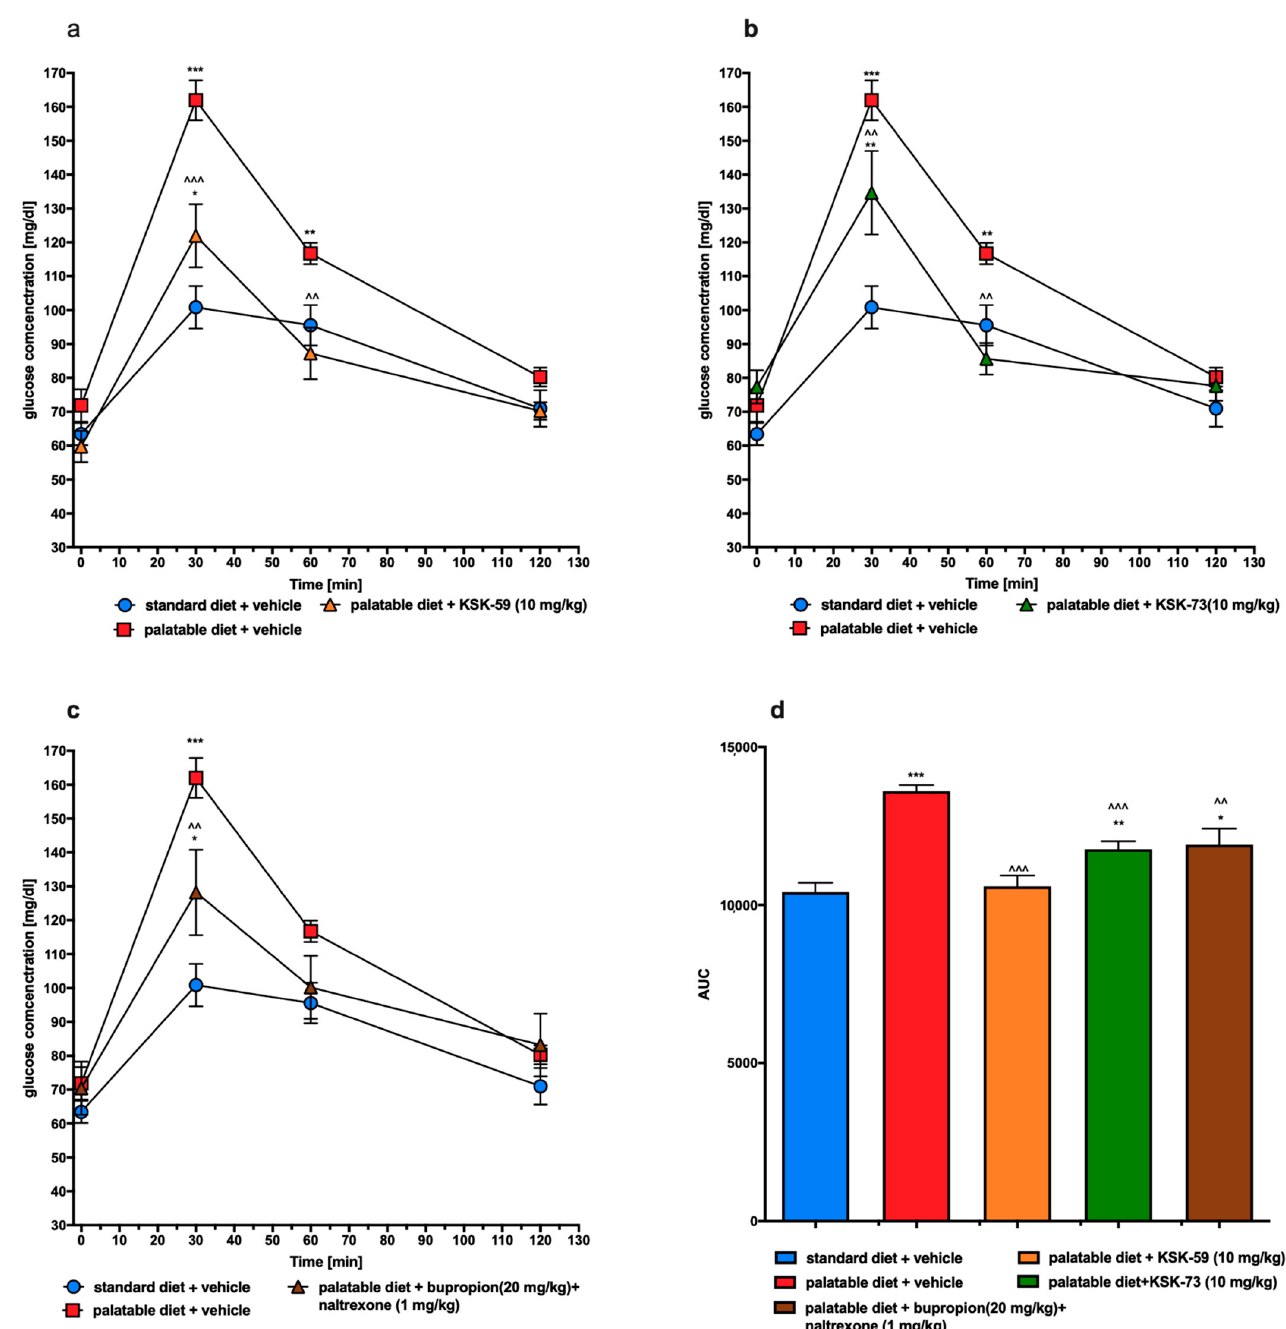
Figure 6. Glucose tolerance test. Results are expressed as means ± SEM, n = 6. ( a – c ) Intraperitoneal glucose tolerance test (IPGTT)—multiple comparisons were performed by two-way ANOVA, Tukey’s post-hoc tests. ( d ) Area under the curve of IPGTT—comparisons were performed by one-way ANOVA, Tukey’s post hoc test. * Significant against control rats fed standard diet; ^ significant against control rats fed palatable diet; * p < 0.05, **, ^^ p < 0.01, ***, ^^^ p < 0.001.